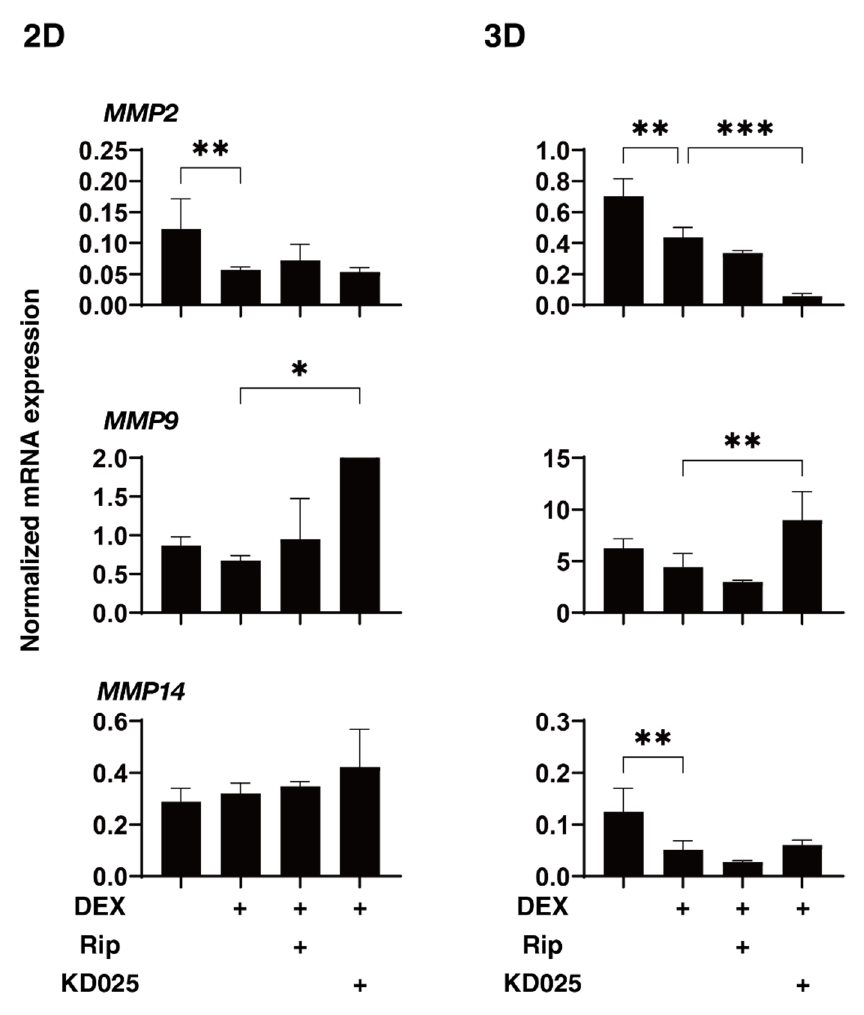
Figure 6. mRNA expression of MMPs in 2D- and 3D-cultured HTM cells. On Day 6, HTM 2D cells and 3D spheroids (non-treated control; NT) and those treated with 250 nM in the absence or presence of 10 µ M ripasudil (Rip) or KD025 were subjected to qPCR analysis to estimate the expression of mRNA of MMP2 , 9 and 14 . All experiments were performed in duplicate using 3 different confluent 6-well dishes (2D) or 15–20 freshly prepared 3D HTM spheroids (3D) in each experimental condition. Data are presented as the arithmetic mean ± standard error of the mean (SEM). * p < 0.05, ** p < 0.01, *** p < 0.005 (ANOVA followed by a Tukey’s multiple comparison test).